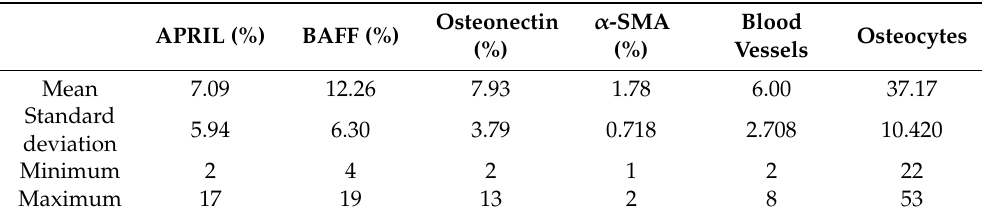
Table 4. Quantification of APRIL, BAFF, osteonectin, α -SMA, blood vessels and osteocytes, in peri-implant bone tissue with peri-implantitis.